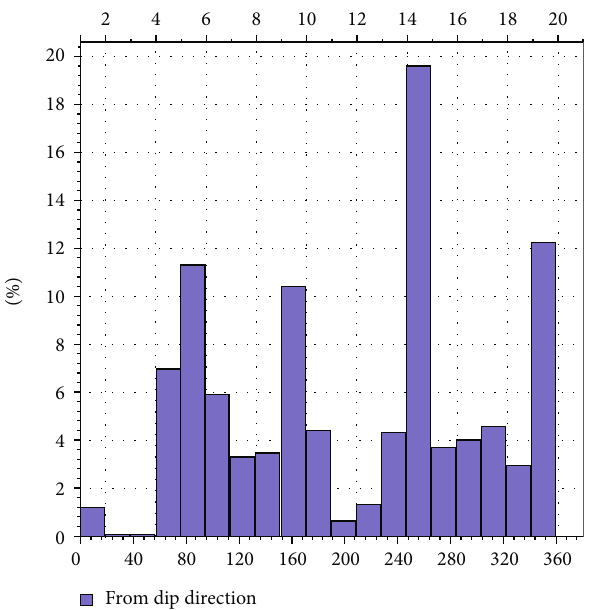
Figure 3: Histogram of fault azimuth distribution.